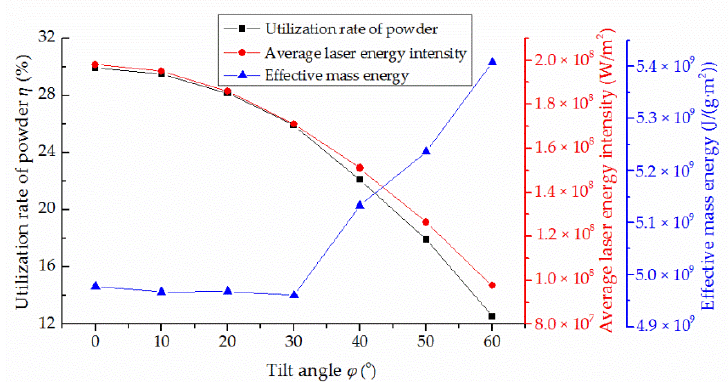
Figure 6. Influence of substrate tilt angle on three parameters.